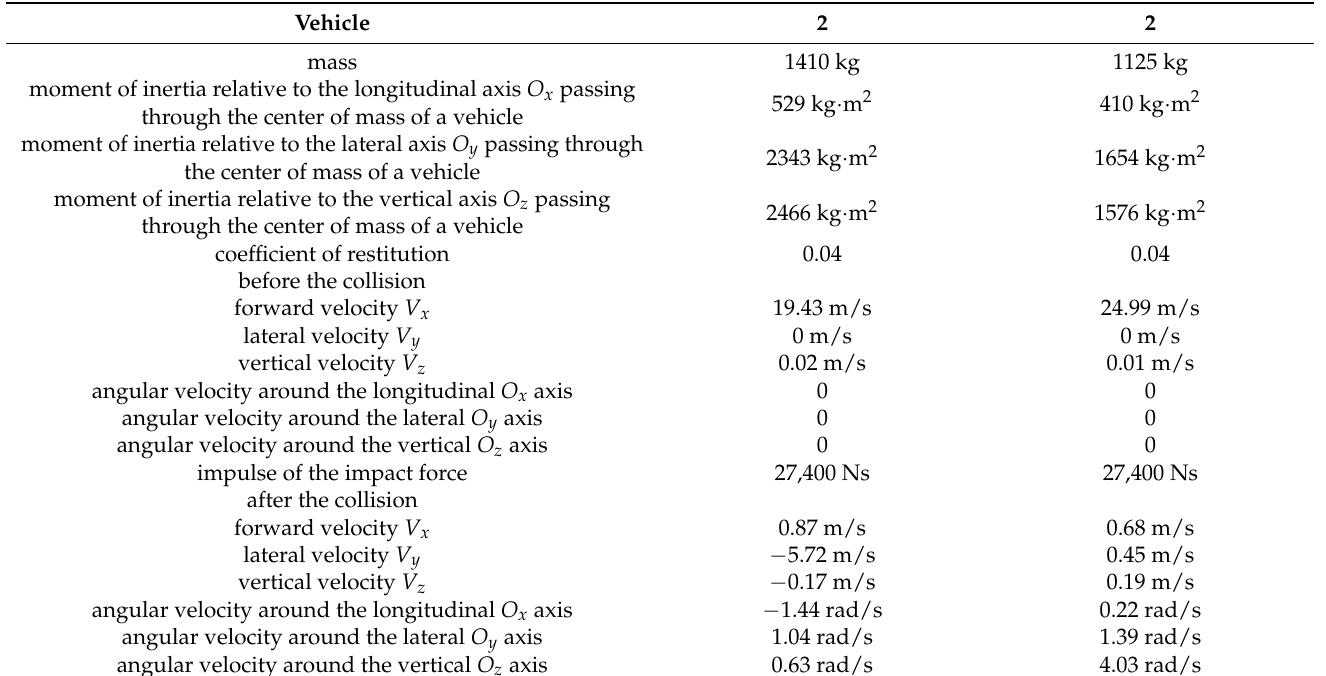
Table 1. Results of a frontal oblique collision simulations of a collision between two passenger vehicles with locked front